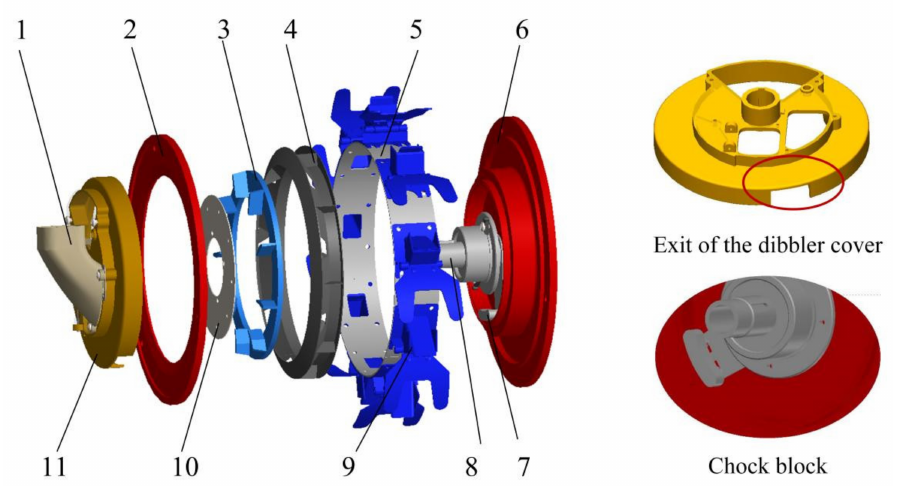
Figure 2. Internal structure diagram of dibbler: (1) seed-delivery tube; (2) side plate 1; (3) seed separation tray; (4) seed-guiding mechanism; (5) belt; (6) side plate 2; (7) chock block; (8) dibbler shaft; (9) duckbill; (10) seed suction tray; (11) dibbler